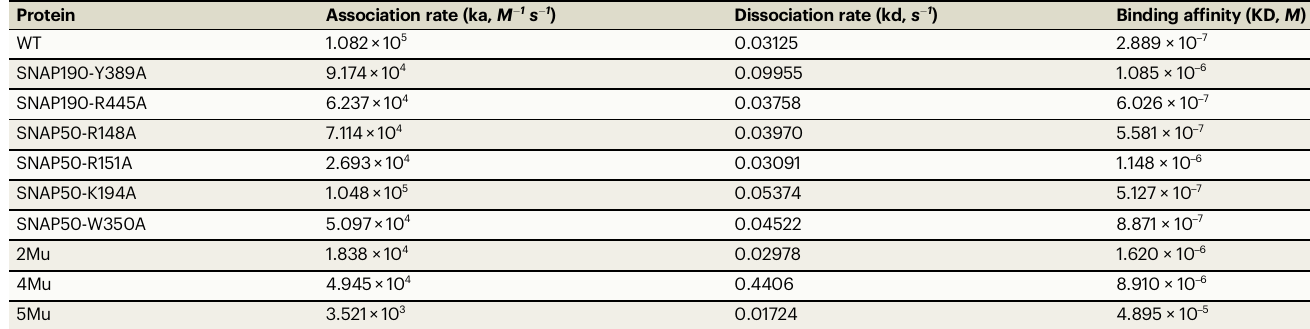
Table 1 | Kinetics and af fi nity constants for wild-type and mutated mSNAPc #2 binding to 25 bp hU6-1 PSE duplex revealed by SPR Protein Association rate (ka, M − 1 s − 1